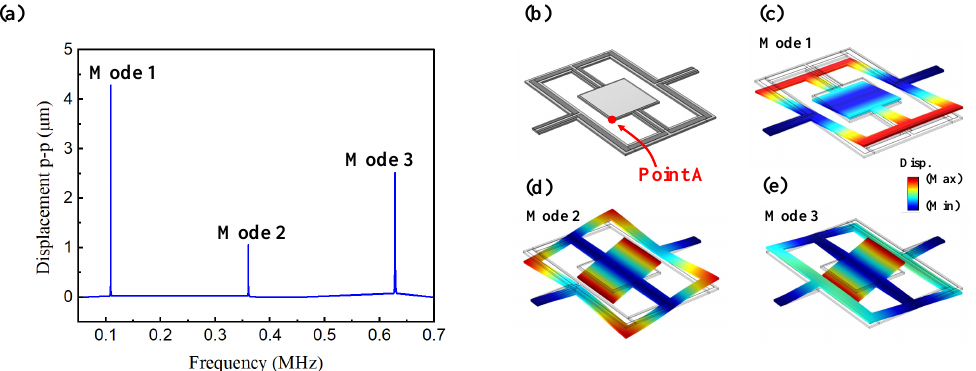
Figure 4. ( a ) Displacement of point A on the designed resonant scanner with driving voltage of 1 V; ( b ) Location of point A on the resonant scanner; ( c ) Mode 1: torsion mode of outer frame (slow scanning mode); ( d ) Mode 2: rocking mode of the outer frame in-phase with mirror. ( e ) Mode 3: rocking mode of the outer frame out-of-phase with mirror (fast scanning mode). The color indicates the displacement magnitude of mode shapes and warm colors indicate larger